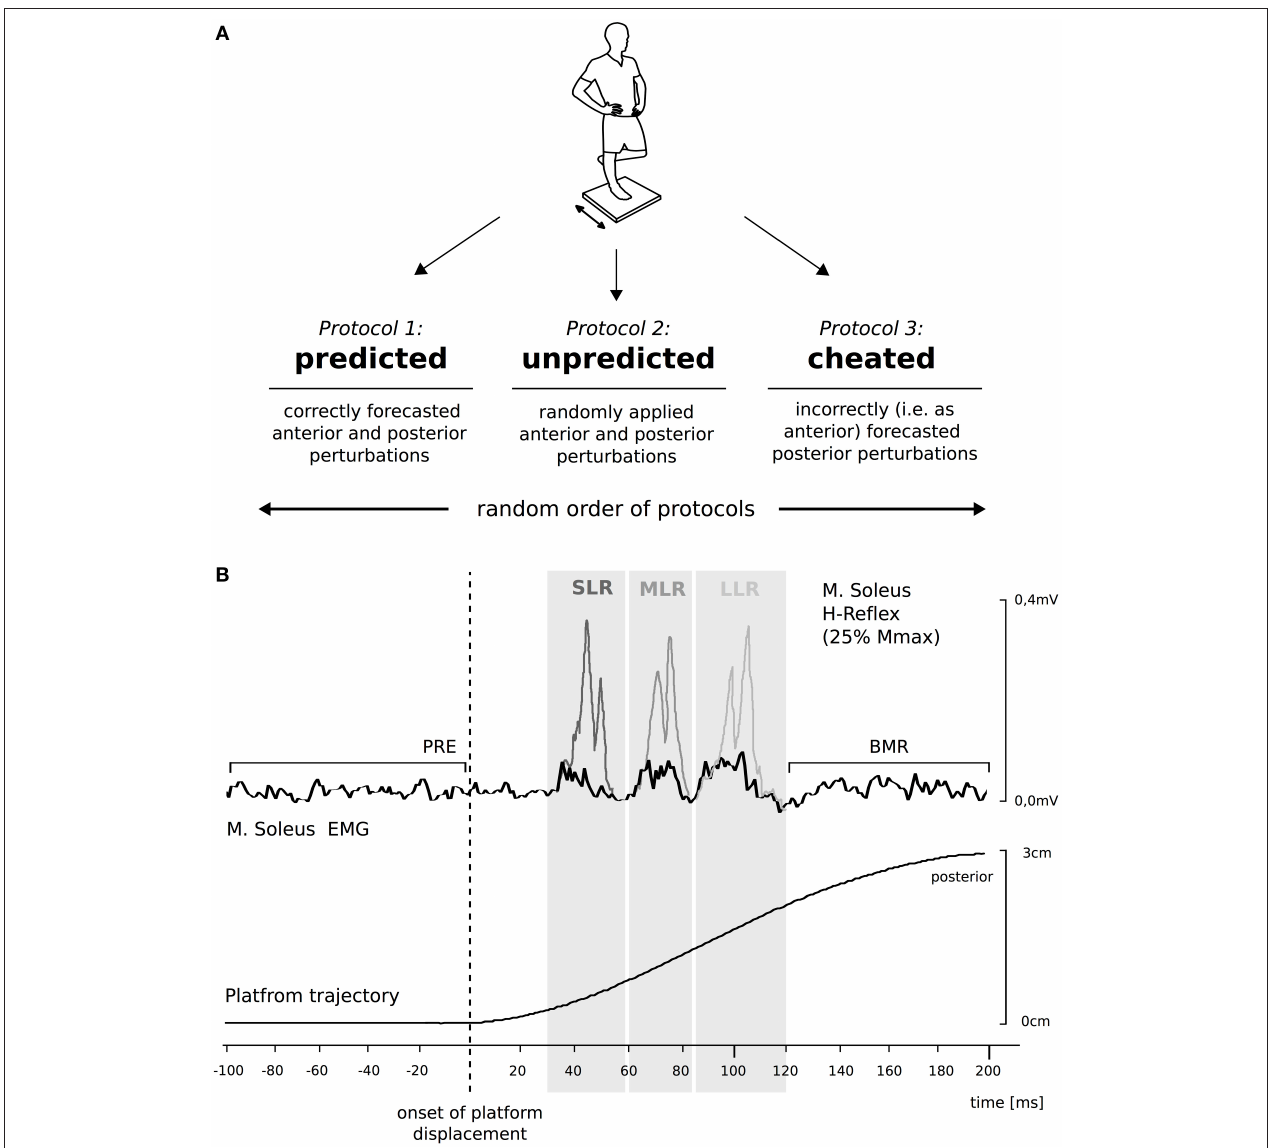
FIGURE 1 | Protocols to establish the effect of anticipation on compensatory postural responses to perturbations. (A) The scheme on the top displays the experimental design. Anticipation was differentiated by the forecast of direction: either the direction was correctly predicted (predicted), occurred randomly (unpredicted), or was wrongly predicted (cheated). The graph at the bottom (B) illustrates the mean trajectory of 10 posterior surface displacements during perturbed stance; time zero corresponds to the onset of perturbation. The Soleus (SOL) background electromyogram (EMG) (black line) of one representative subject comprising the mean of 10 trials is displayed. SOL H-reflexes (gray lines) were timed to coincide with the peaks of short- (SLR, dark gray graph), medium- (MLR, gray graph), and long-latency responses (LLR, light gray graph). Background EMG, H-reflexes, belated muscle responses (BMR) and M-waves (not illustrated) were compared between the three protocols by analyzing the integrals below the curves in the respective time intervals (gray boxes). Protocol 3: Cheated–Perturbation Direction Protocol 2: Unpredicted–Perturbation Direction Was Unknown and Not Forecasted